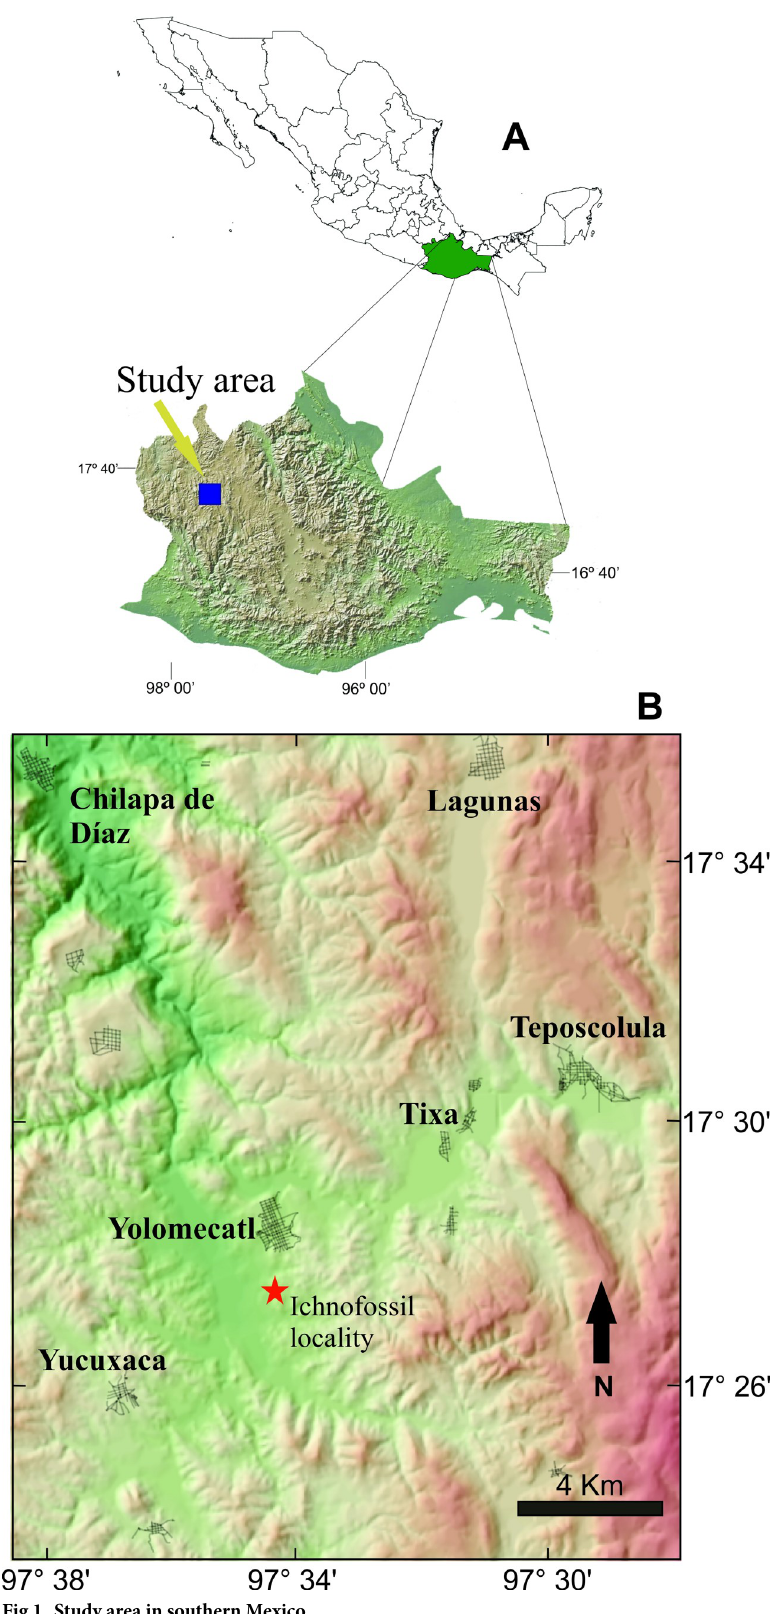
Fig 1. Study area in southern